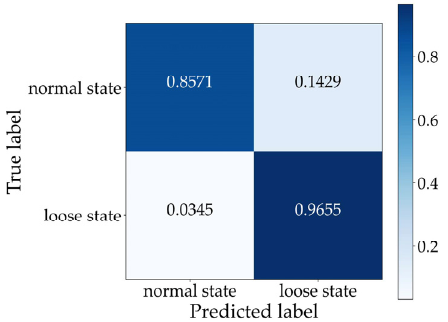
Figure 8. Clustering visualization results of fastener state feature based on t-SNE.